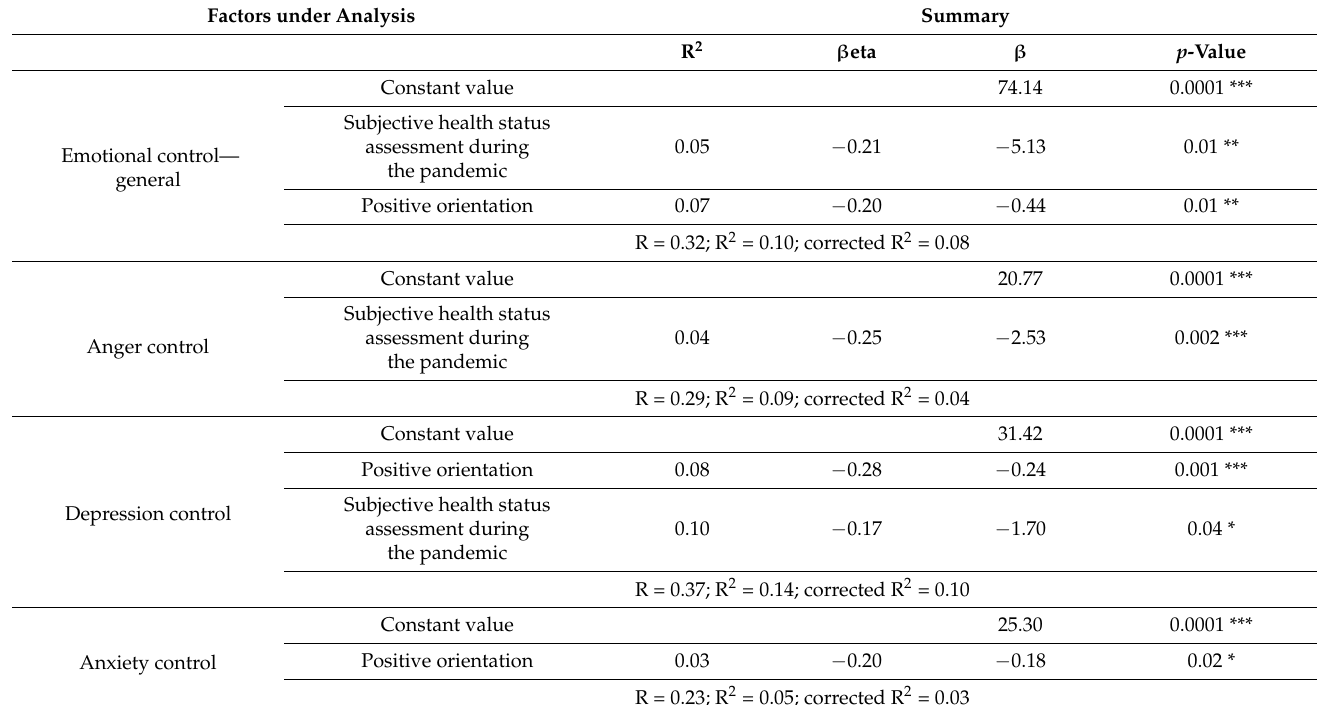
Table 6. Multiple regression results—predictors of emotional control—general, concerning anger, depression and anxiety in the Slovak